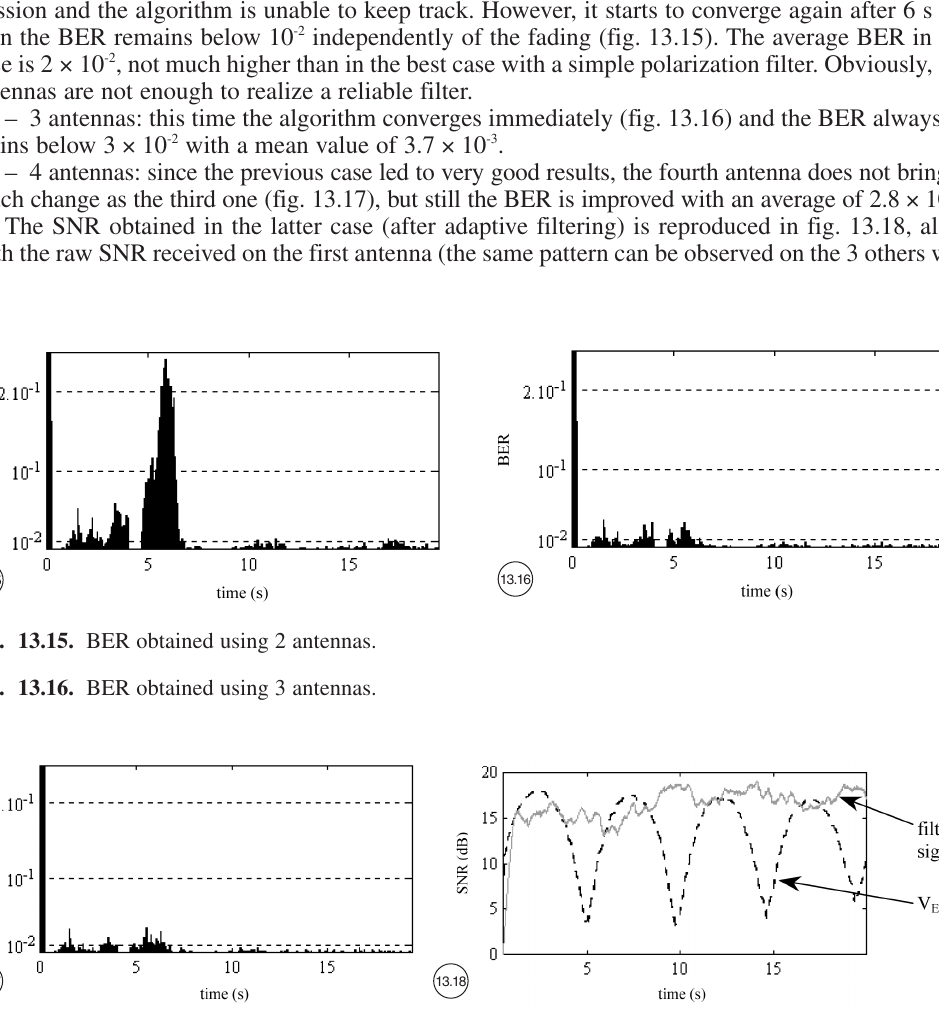
Fig. 13.17. BER obtained using 4 antennas. Fig. 13.18. Comparison of SNR on antenna V EW with SNR after